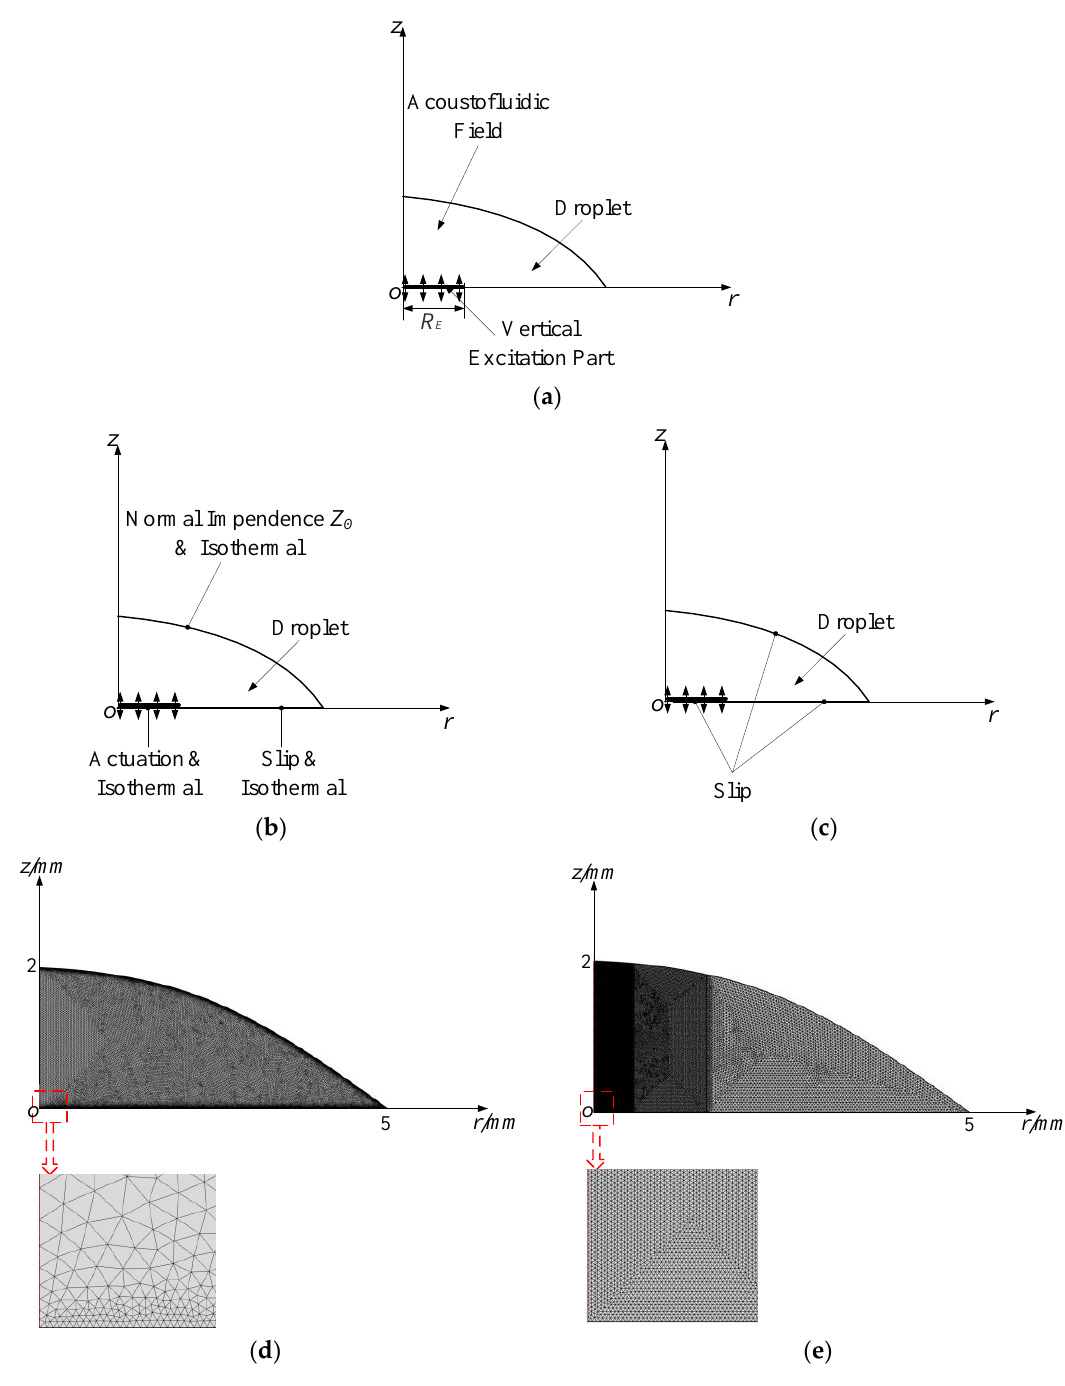
Figure 2. ( a ) 2D axisymmetric model of the acoustofluidic field in the droplet-ultrasonic substrate system. ( b ) Boundary condition for the acoustic field in the droplet-ultrasonic substrate system. ( c ) Boundary condition for the acoustic streaming field in the droplet-ultrasonic substrate system. ( d ) Meshed model for the acoustofluidic field in the droplet-ultrasonic substrate system under the simulation scheme of the PM. ( e ) Meshed model for the acoustofluidic field in the droplet-ultrasonic substrate system under the simulation scheme of the RSM.